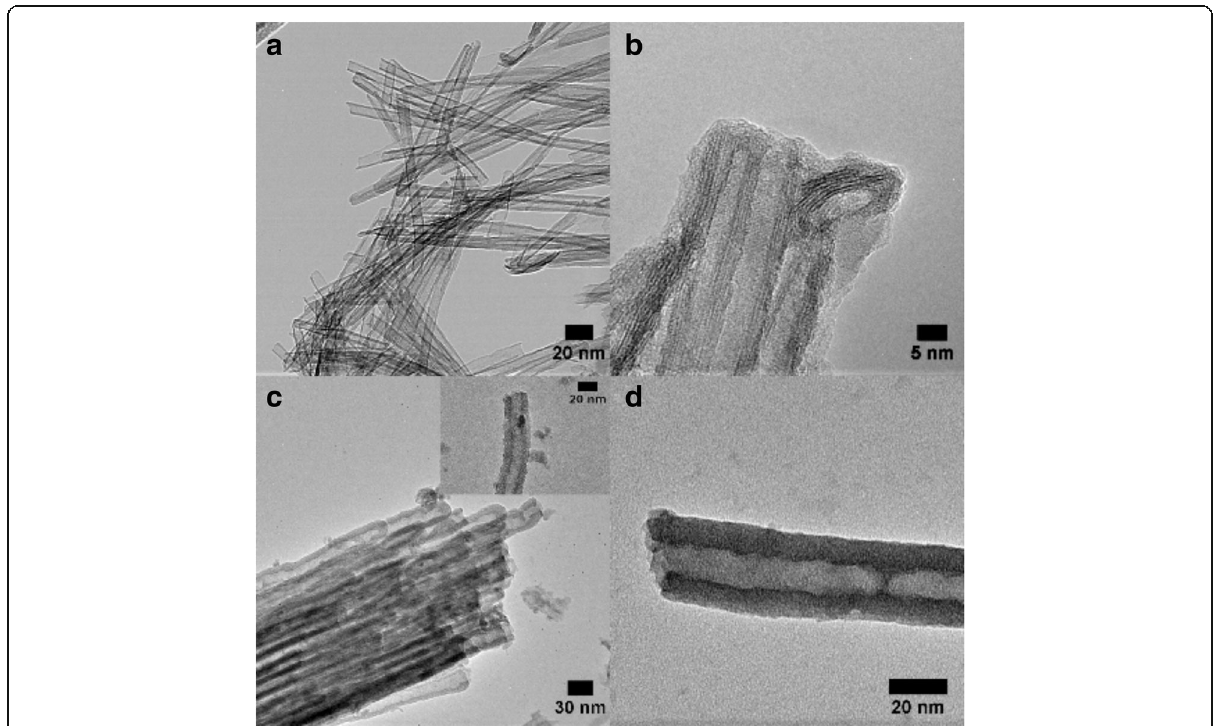
Fig. 3 TEM images of a the TNT A,T prepared by chemical processing, b HR-TEM micrograph showing the structure of multiwalled nanotubes, c the single-walled crystalline nanotubes prepared (TNT A ) by RBA, and d the amorphous nanotubes (TNT Amor )